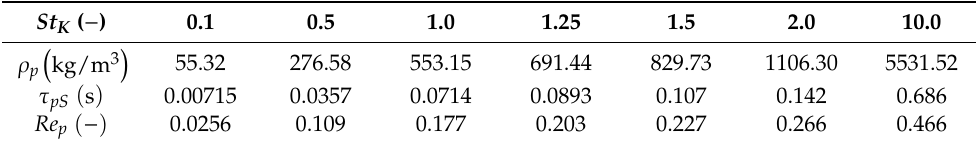
Table 2. Properties of the particles considered in this